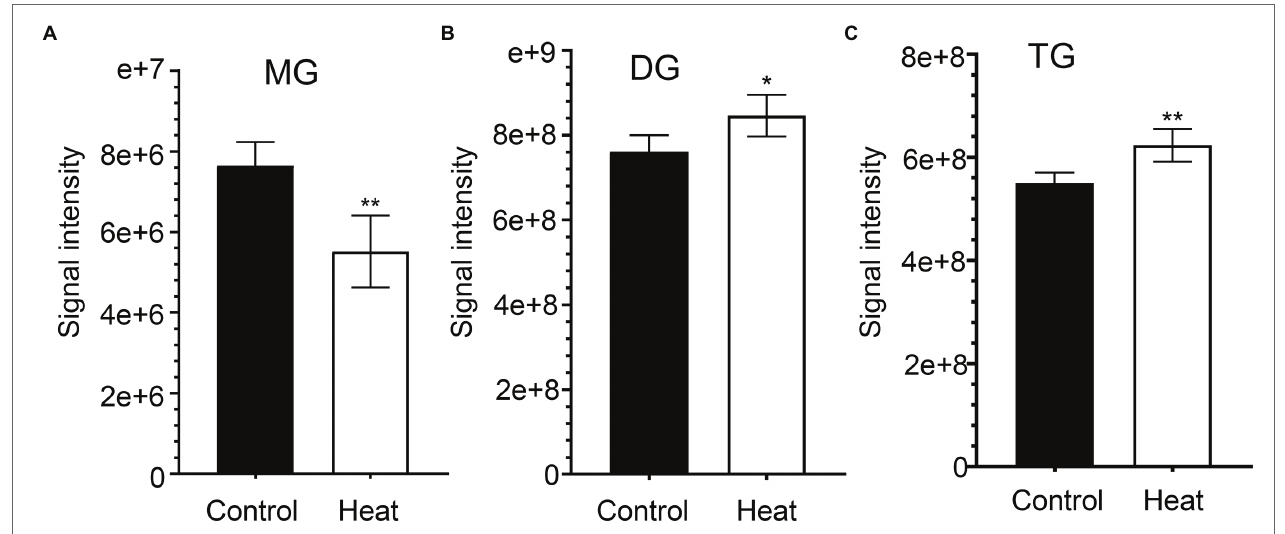
FIGURE 1 | Effects of heat stress on accumulation of glycerolipids in leaves of Begonia grandis . (A) monoacylglycerol (MG); (B) diacylglycerol (DG); (C) triacylglycerol (TG). Fully extended leaves detached from 173-d-old plants of B. grandis were at control condition (22 ° C for 2 h) or challenged with heat stress (45 ° C for 2 h). Values shown are mean ± SD ( n = 5). * p < 0.05, ** p < 0.01, two-sided Student’s t-